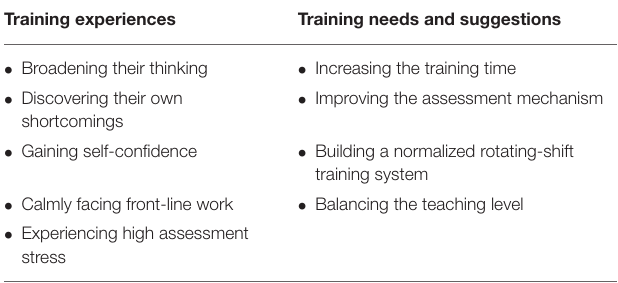
TABLE 3 | Training experiences and needs of ICU general nurses against the background of normalized COVID-19 prevention and control. Training experiences Training needs and